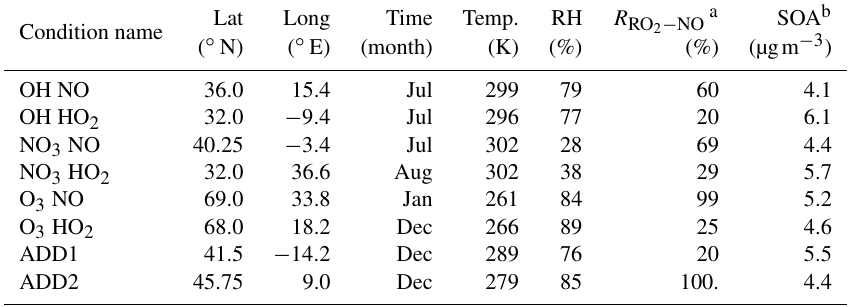
Table 6. Geographic and meteorological conditions of the training dataset. The table headings, from left to right, indicate the name, latitude, longitude, time period, average temperature, average RH, average daily NO reaction ratio, and simulated total SOA concentration of the training conditions.